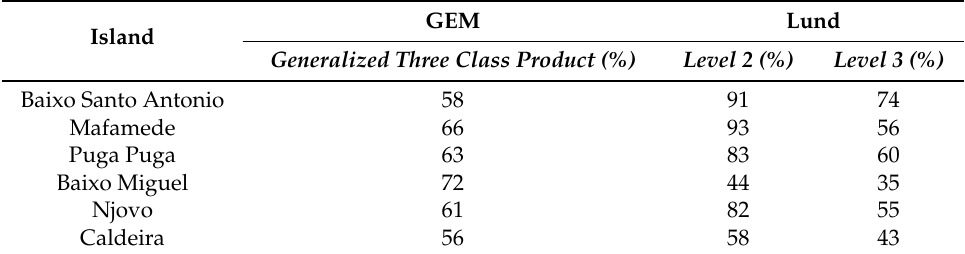
Table 6. Accuracy assessment results for the pixel based and object based maps. GEM Lund Island Generalized Three Class Product (%) Level 2 (%) Level 3